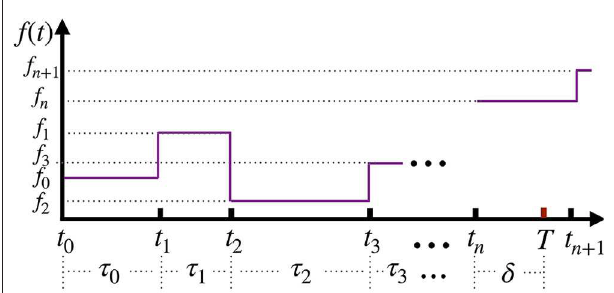
FIGURE 1 | The schematic description of the telegraphic active noise f ( t ) considered in our Langevin equation 1. The protocol of the noise is given by f ( t ) f i for t [ t i , t i ], where the noise strength f i and the duration time = ∈ + 1 t i t i are random variables specifying the statistical properties of f ( t ). It τ i ≡ + 1 − is a renewal process such that the sequences of obtained from the PDF P ( f ) and P ( τ ),